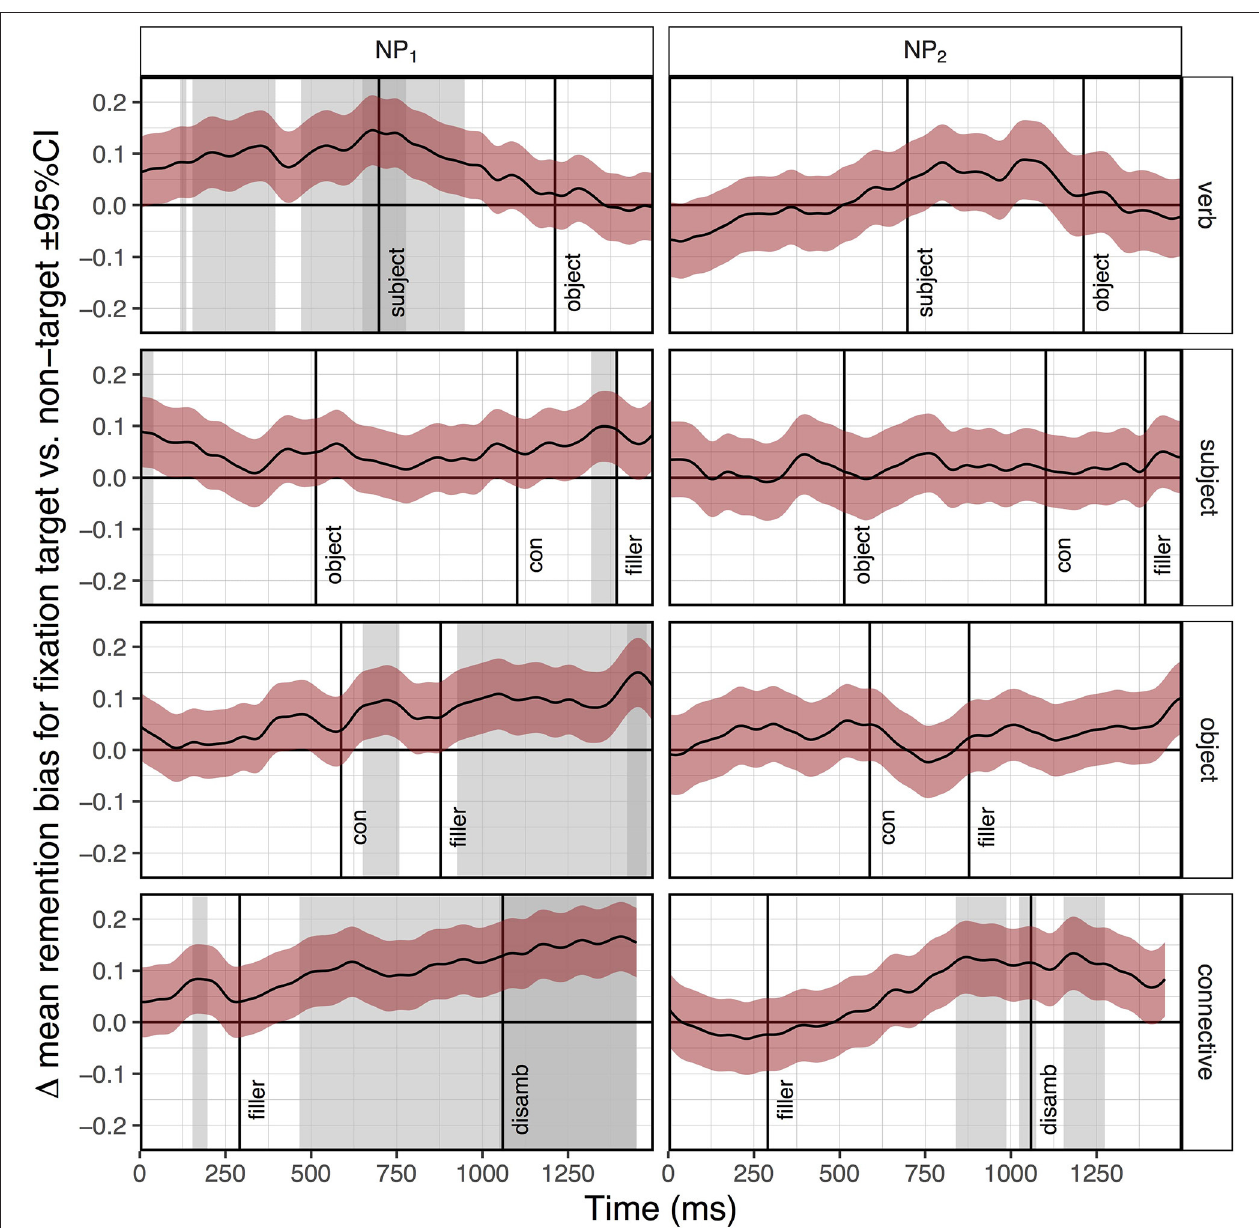
FIGURE 6 | Exploratory analysis: the difference in mean remention bias between trials in which the target was fixated and trials in which the target was not fixated at a given millisecond. Columns show the two different targets (NP 1 and NP 2 ) and rows show the different linguistic items to the onset of which the eye-movement data were time-locked. Vertical lines indicate the mean onsets of the auditory regions. Shaded areas indicate time regions where the difference was statistically significant after false discovery rate correction (light shading: α = 0.05; dark shading: α =